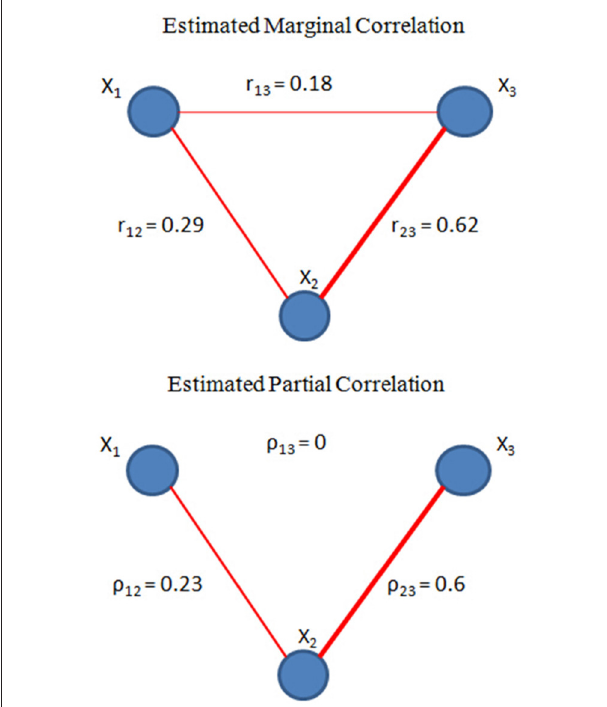
FIGURE 1 | Toy example on partial correlation (bottom) and full correlation (top). Within a 3-node network, where X 1 0.3X 2 + ε 1 , X 3 = = 0.8X 2 N(0,1), we estimated the connectivity based on ε 2 and ε 1 , ε 2 , X 2 + ∼ iid full correlation and partial correlation. As shown in the figure, partial